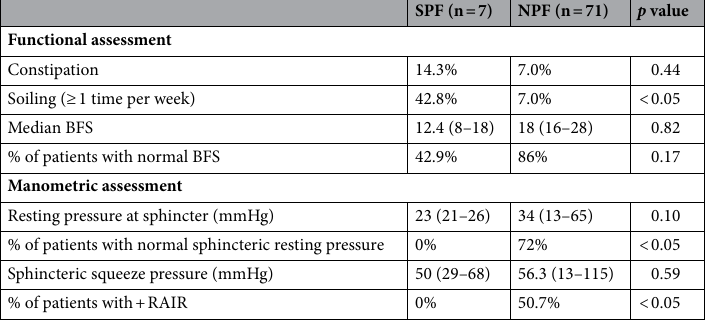
Table 3. Comparison of clinical and manometric results of patients between SPF verus